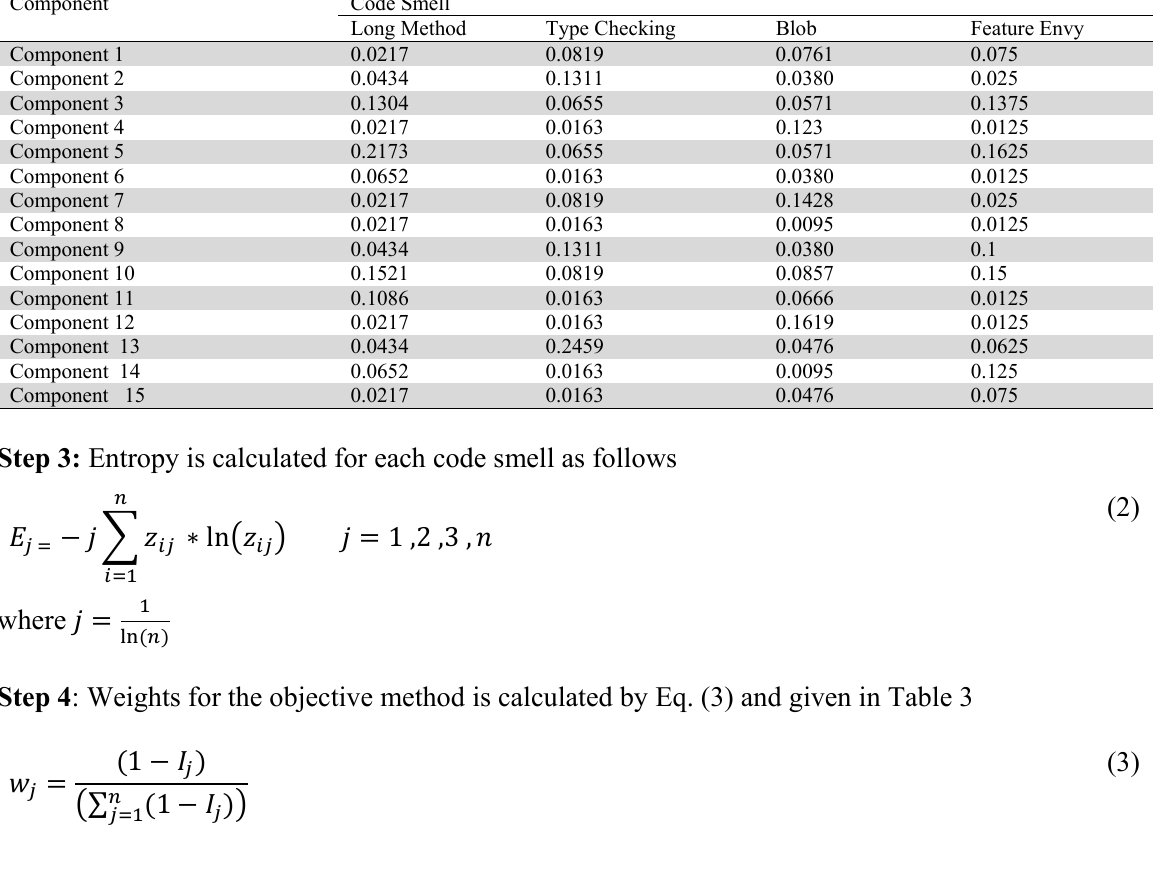
Long Method Type Checking